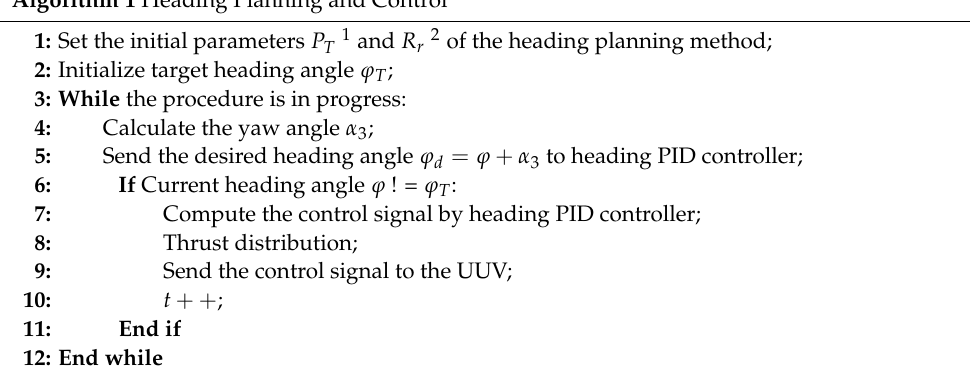
Algorithm 1 Heading Planning and Control